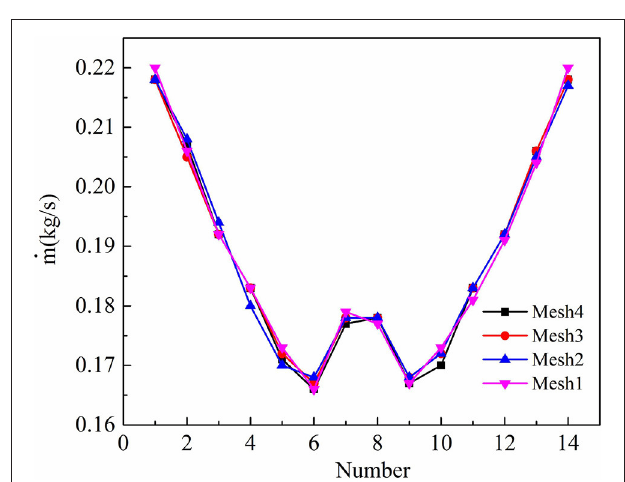
FIGURE 5 | Grid independence